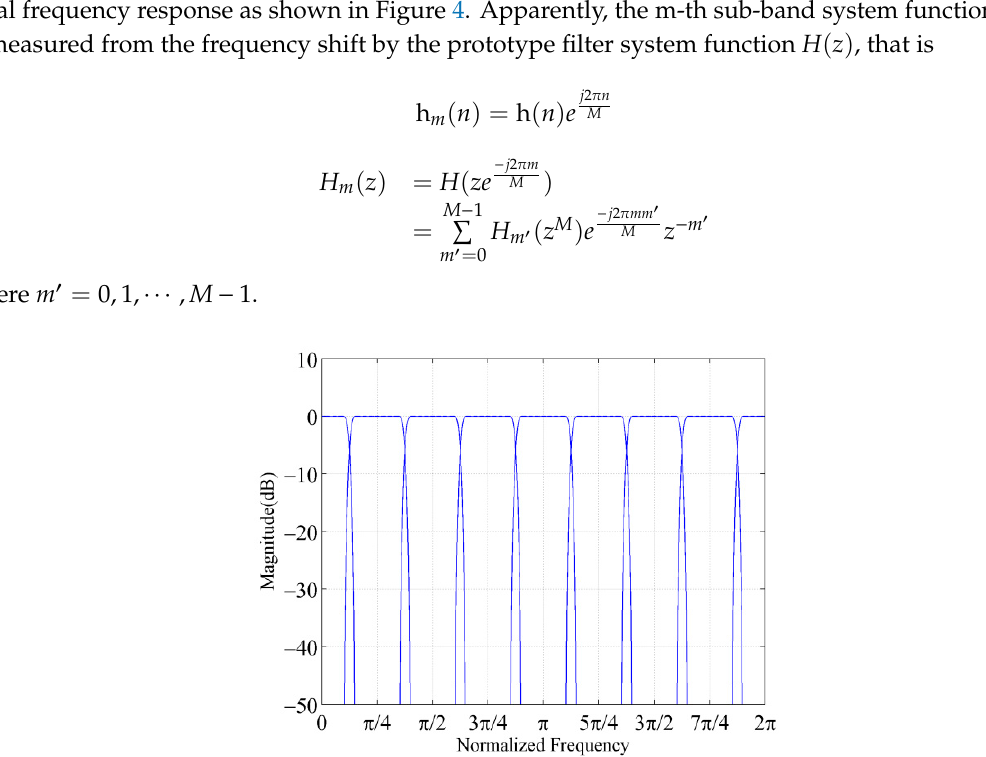
Figure 4. Ideal frequency response of the P-DFTFB.